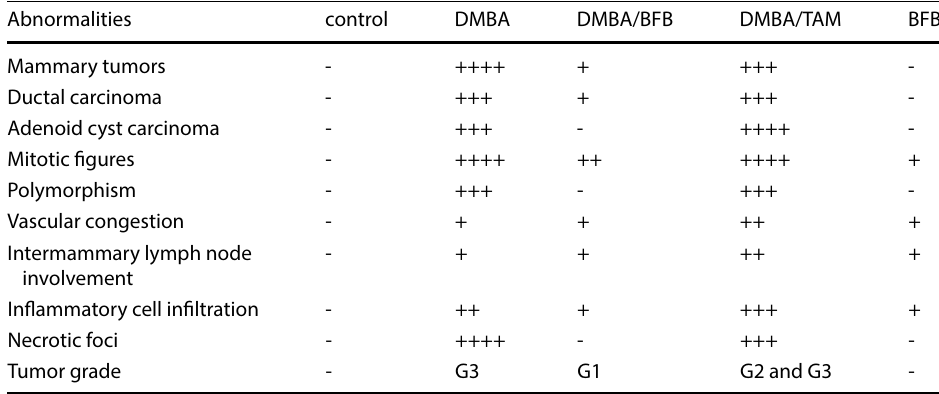
in mammary gland and mammary